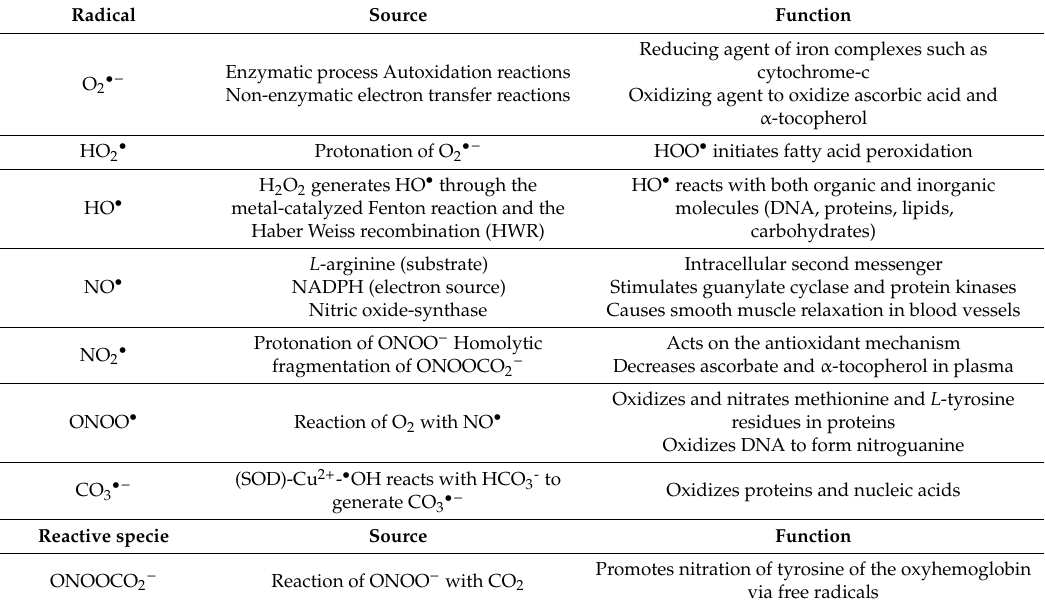
Table 3. The most representative radicals and the reactive specie ONOOCO 2 − produced in biological aerobic systems with sources and